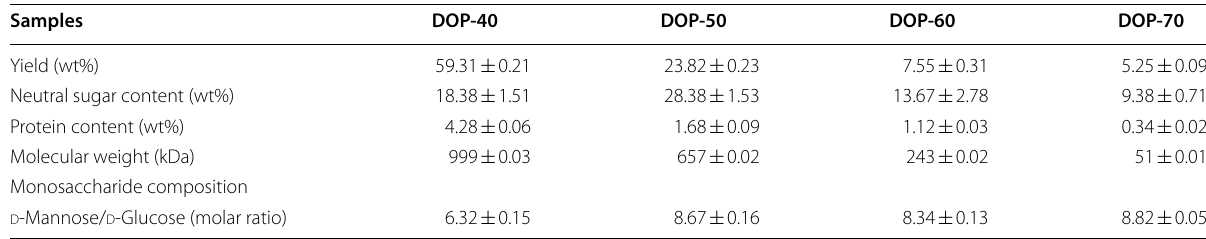
Table 1 The yield and physicochemical properties of polysaccharide fractions from Dendrobium officinale stems